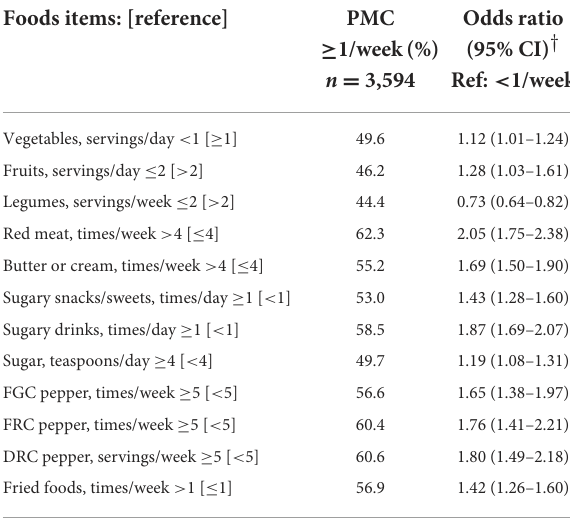
TABLE 4 Frequency of intake of other foods associated with processed meat consumption at least once a